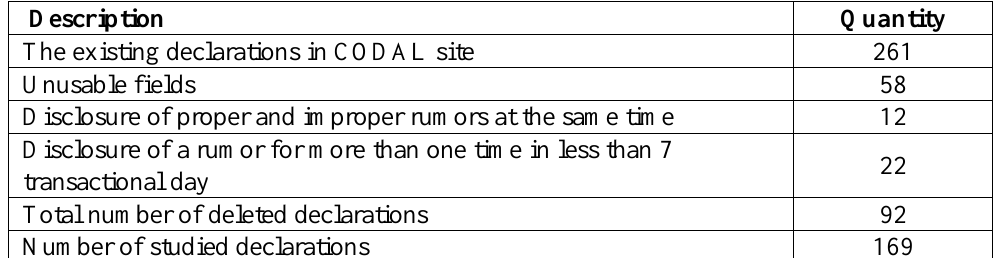
Table 1. Process of screening of clear rumor declarations as members in the sample within the